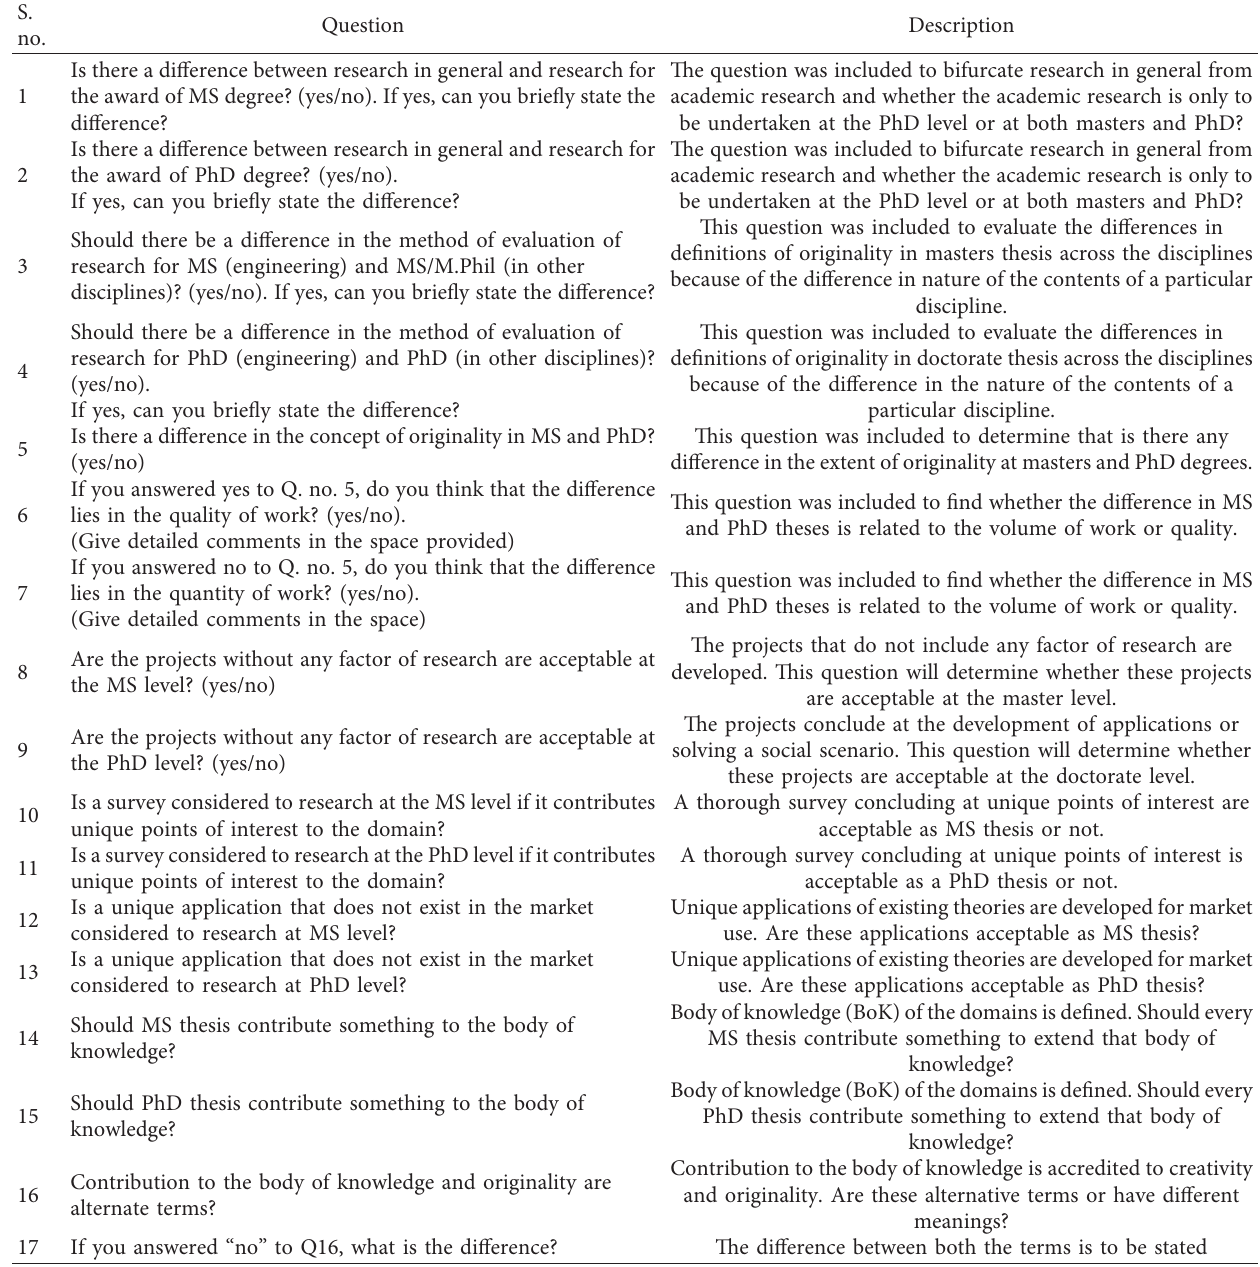
Table 2: Questionnaire—the concept of originality (Annex